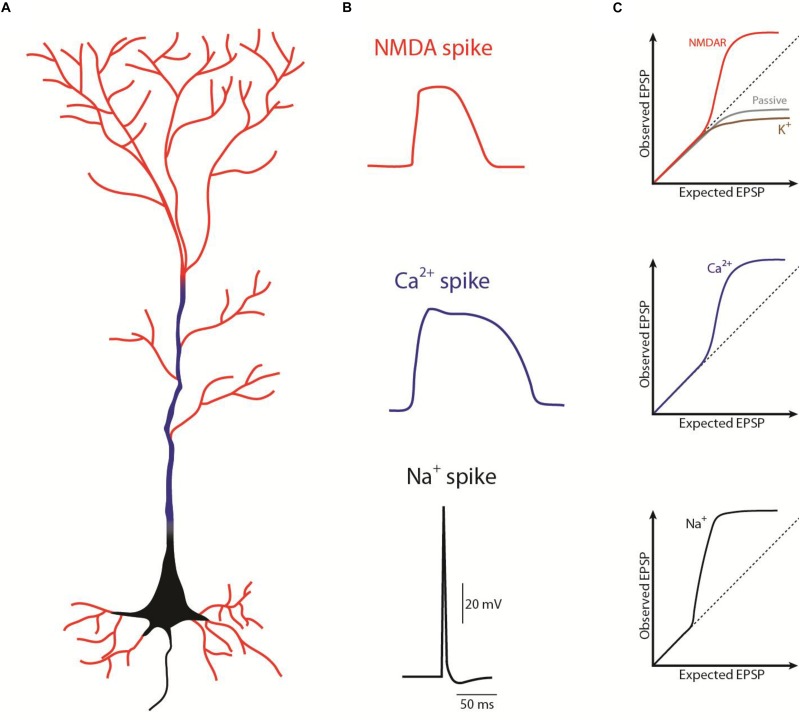
Schematic representation of the different spikes in a pyramidal neuron. (A) Representation of where the different spikes take place: NMDA spikes (red) in “thin” dendrites, Ca2+ spikes (blue) in “thick” dendrites, Na+ spikes or action potential (black) in the axon (as in Larkum et al., 2009). (B) Waveform of the different spike (as in Antic et al., 2010). (C) Contribution of the different ion channels on the excitatory postsynaptic potentials (EPSP) summation; supralinear summation above the dashed line, sublinear summation bellow the dashed line. EPSP summation properties depends not only on the ion channels but on the combination between those, morphology (dendritic diameter, distance from soma, and branchpoints) and synaptic strength. A combination of those can give rise, for example to a linear summation (as in Tran-Van-Minh et al., 2015).